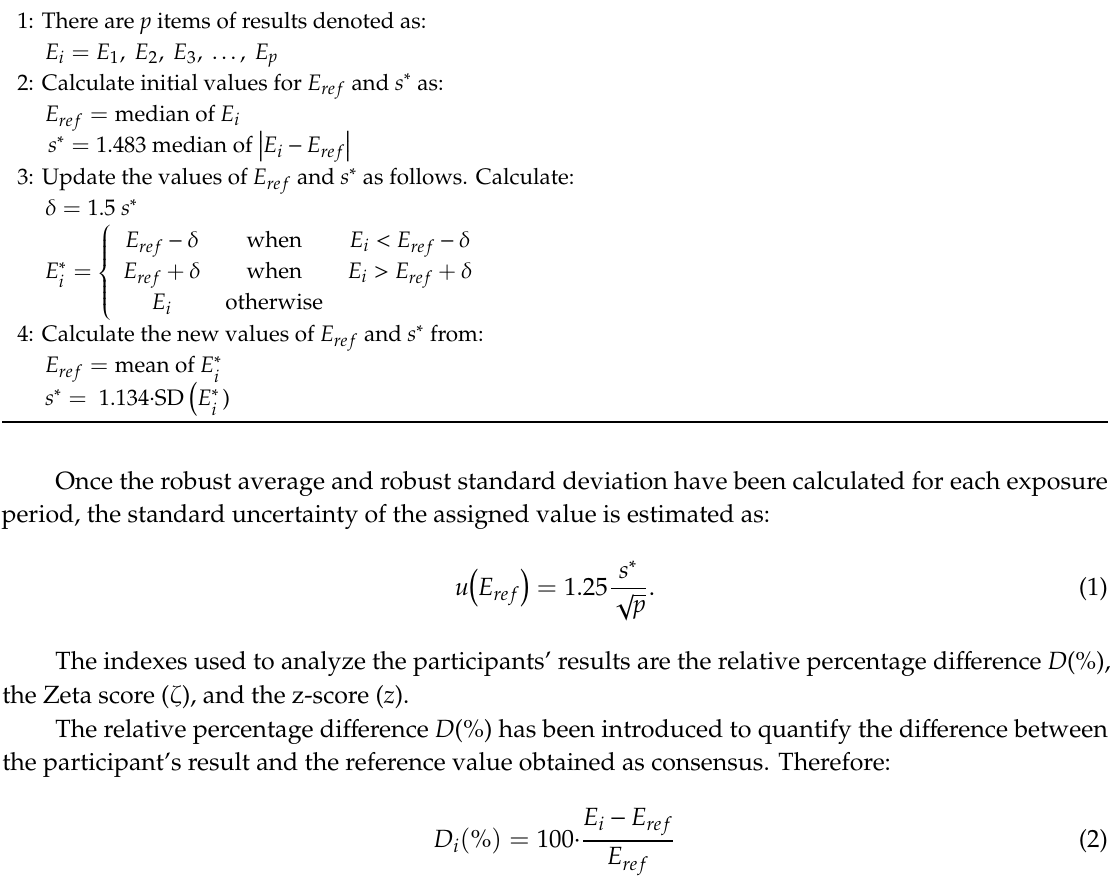
Algorithm 1. Algorithm used to calculate the robust average E ref and robust standard deviation s * taken from ISO 13528:2015 denoted as Algorithm A. The parameters are updated following the steps 3 and 4 iteratively until the process